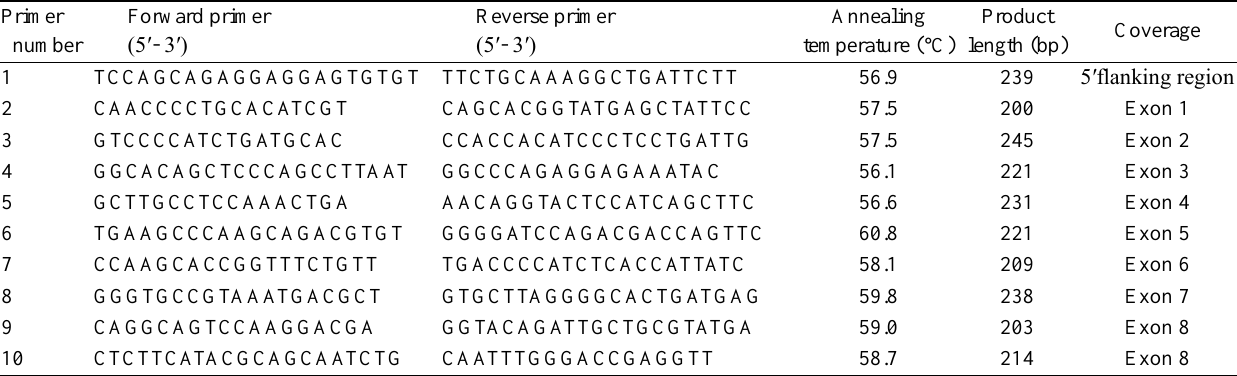
Table 1. Primers for screening SNPs in the chicken PLIN1 gene Primer Forward number